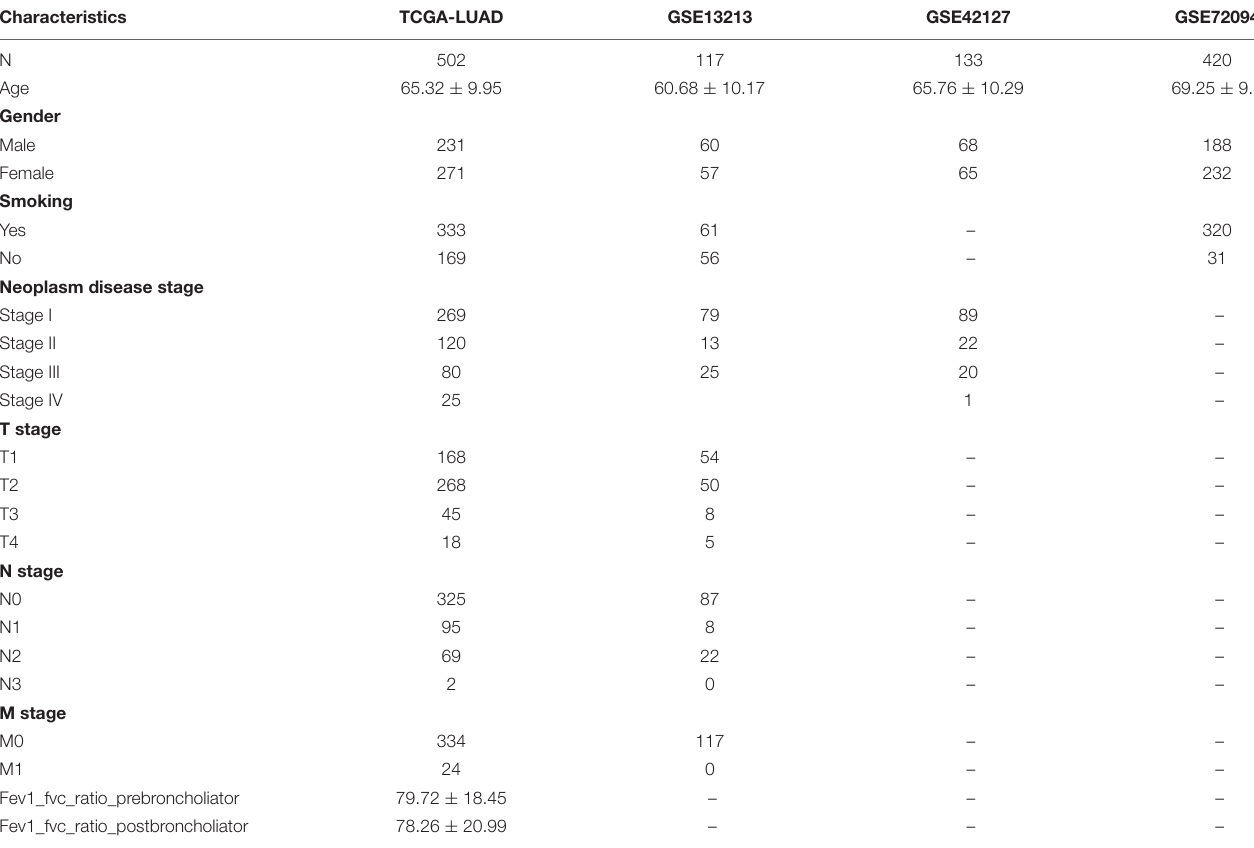
TABLE 1 | Baseline characteristics of the patients in this